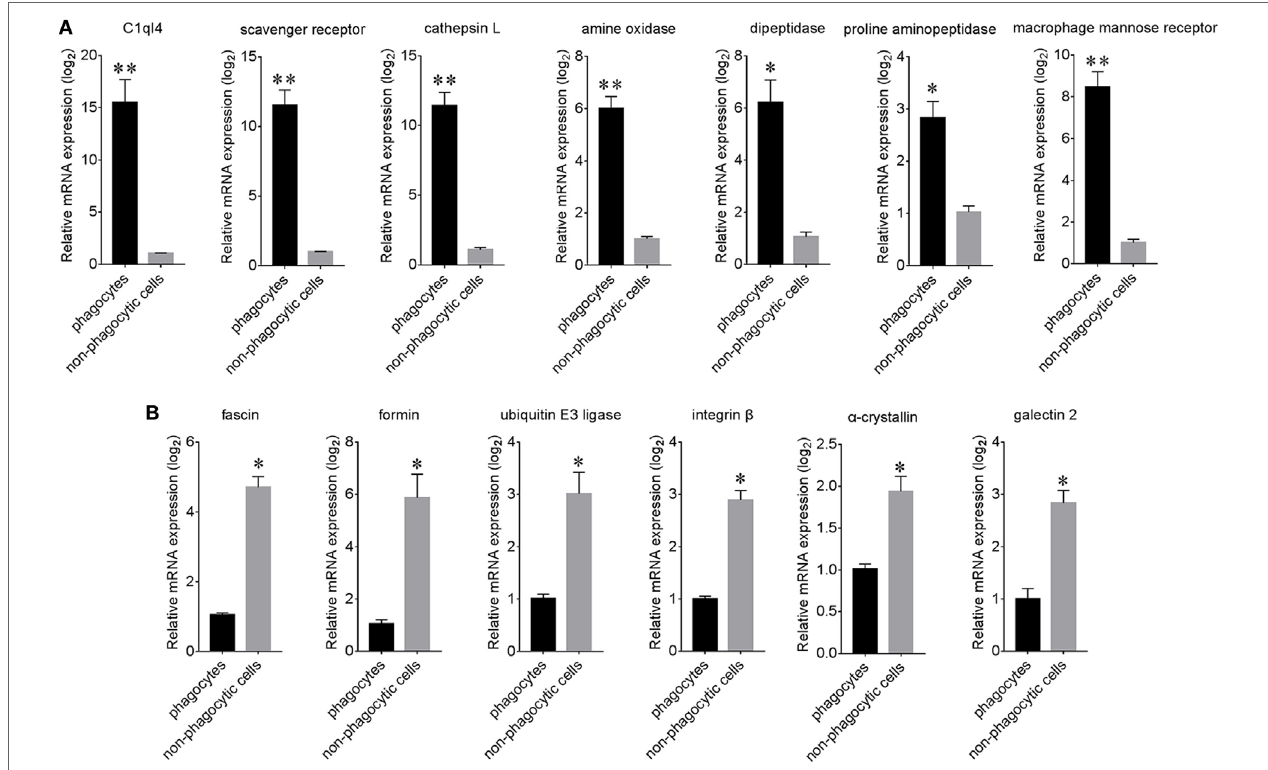
FigUre 7 | Relative expression analysis of differentially expressed proteins (DEPs) using qPCR. The expression of significantly high expressed (a) and low expressed (B) proteins within phagocytes and non-phagocytic hemocytes was determined using qPCR. Results are indicated here at the messenger RNA level for each phagocyte gene in relation to their level in non-phagocytic hemocytes ( n = 6), * p < 0.05, ** p < 0.01.